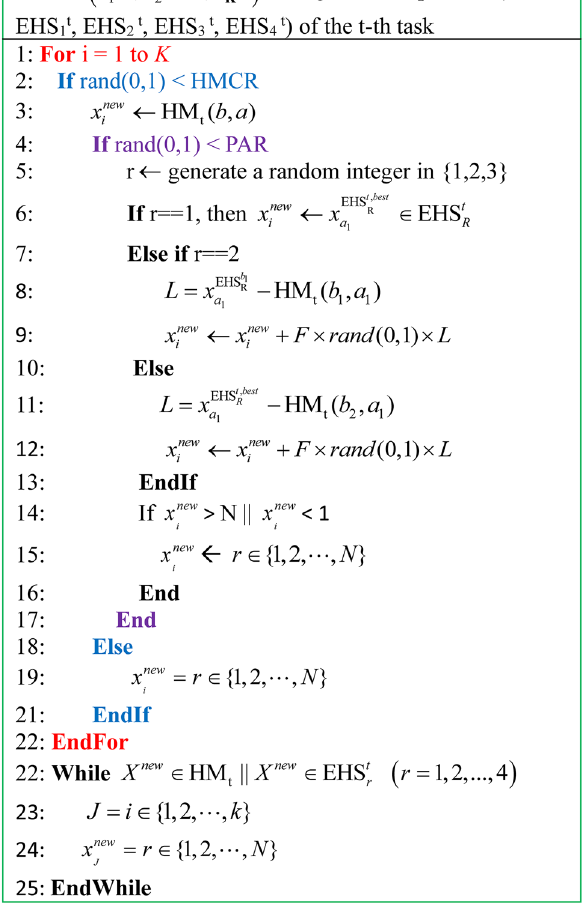
focus of consideration when employing the pitch adjustment